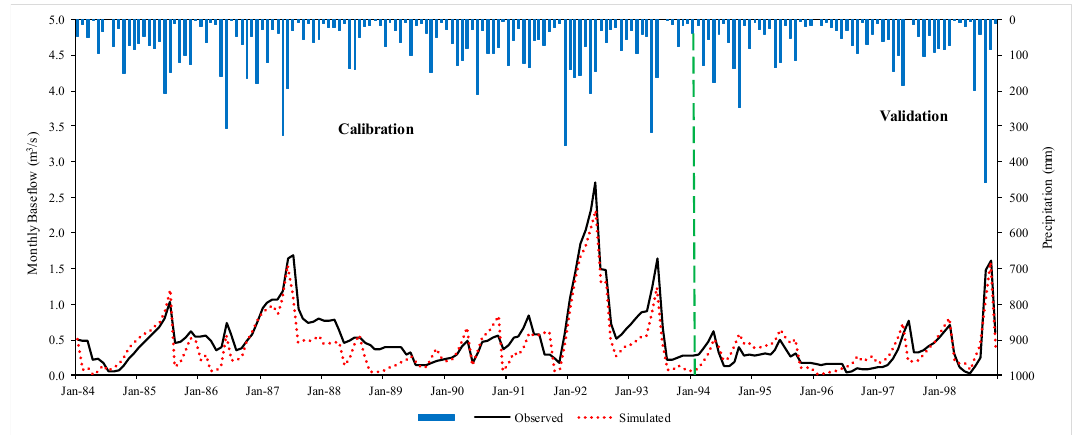
Figure 9. Observed and simulated time series streamflow for the Walzem Creek watershed during calibration and validation periods.